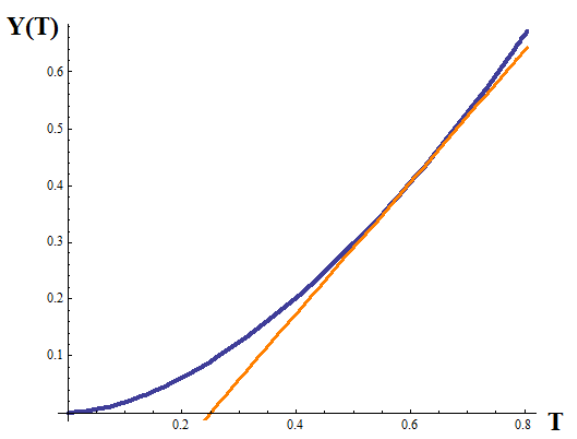
Figure 3. The curve and its tangent in the fractional Λ -space for γ = 0.6 and Y = 0.6 .